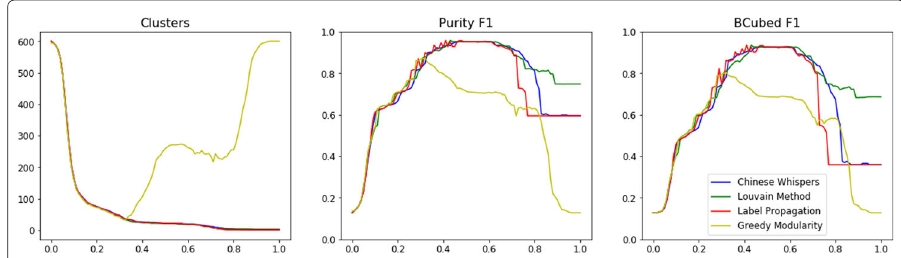
Fig. 3 Semantic frame induction results using different community detection algorithms. The horizontal axes refer to the neighboring threshold used to create the